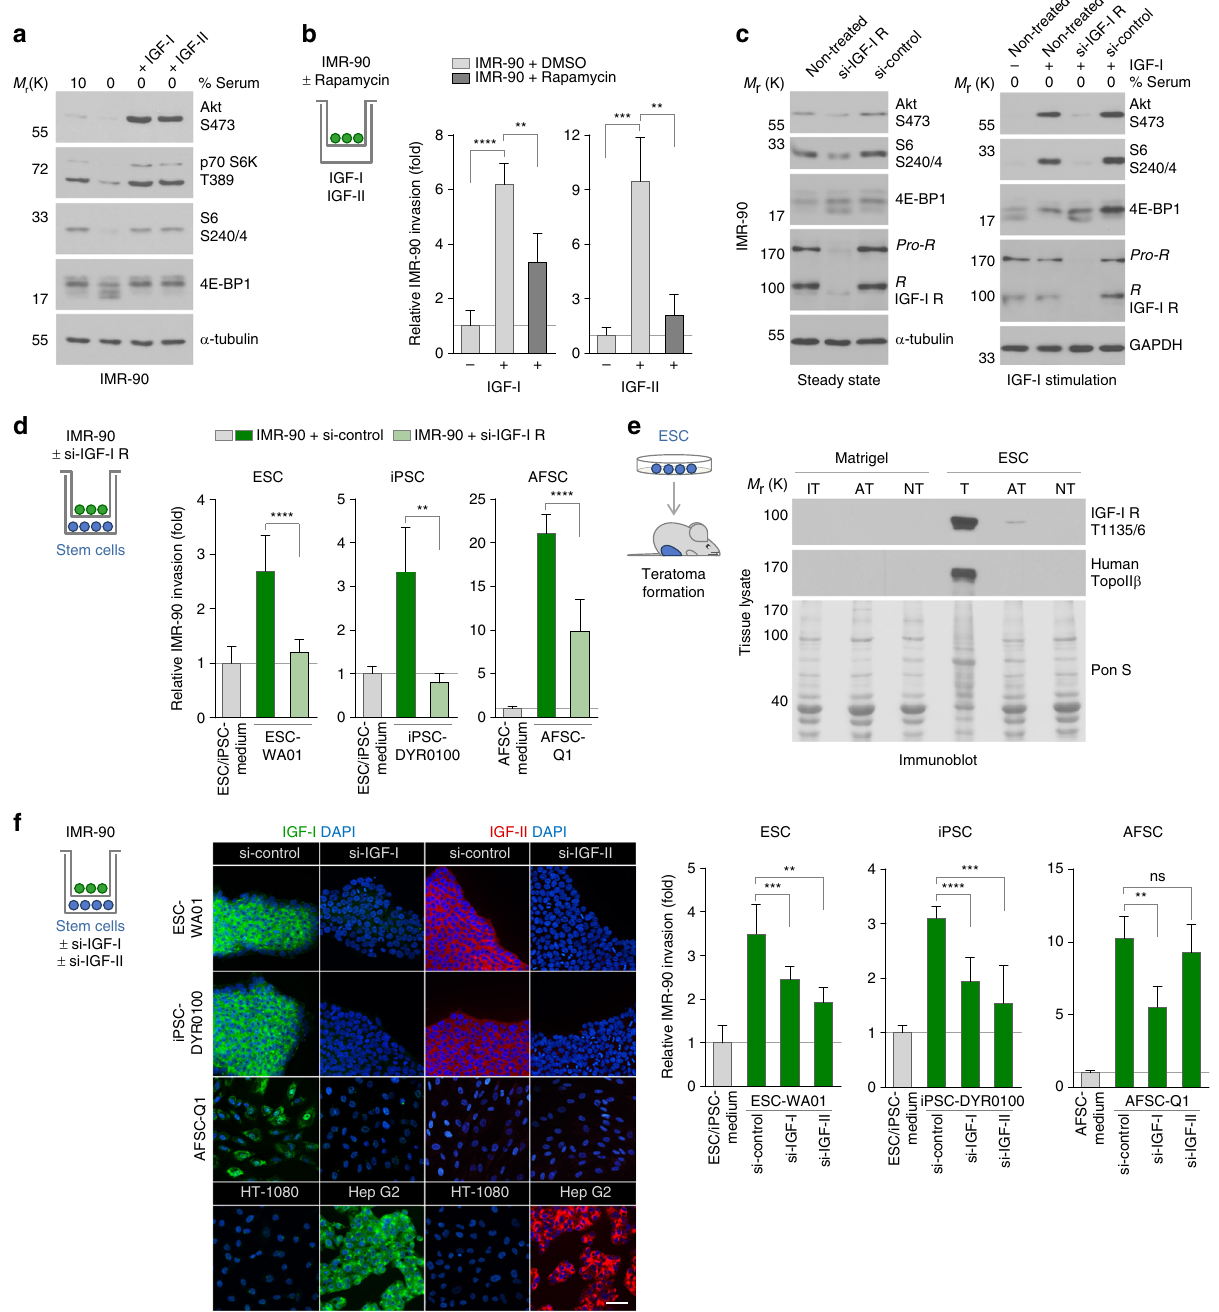
Fig. 5 Stem cell-secreted IGFs activate the IGF-I receptor to promote target cell invasion. a Immunoblot for the detection of mTOR signalling proteins in serum-deprived IMR-90 cells stimulated with IGF-I or IGF-II. b Transwell invasion assay of Rapamycin-treated IMR-90 fi broblasts upon IGF stimulation ( n ≥ 3; mean ± s.d.). c Immunoblots for the detection of mTOR signalling proteins in IGF-I receptor-depleted IMR-90 cells under steady state conditions ( left panel ) or upon IGF-I stimulation ( right panel ). d Transwell invasion assay of IGF-I receptor-depleted IMR-90 fi broblasts upon co-culture with stem cells ( n ≥ 6; mean ± s.d.). e Immunoblot of tissue lysates from Matrigel- or ESC-injected mice for the detection of phosphorylated IGF-I receptor. The absence of human cells from non-teratoma tissues and equal loading was veri fi ed by detection of human topoisomerase II β and Ponceau-S staining. f Transwell invasion assay of IMR-90 fi broblasts co-cultured with IGF-I- or IGF-II-depleted stem cells ( n ≥ 3; mean ± s.d.). Knockdown ef fi ciency was evaluated via immunostaining of endogenous IGF-I and IGF-II. IGF detection in stem cells was further veri fi ed by co-analysing somatic (HT-1080, Hep G2) control cell lines. Scale bar , 50 μ m. ** P < 0.01; *** P < 0.001; **** P < 0.0001; ns, P > 0.05 (not signi fi cant) by unpaired, two-tailed Student ’ s t -test analysis. n refers to biological